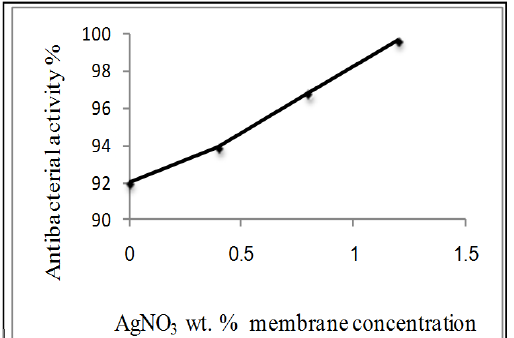
Fig. 14. Antibacterial activities at different (AgNO /Nylon 6) membrane 3